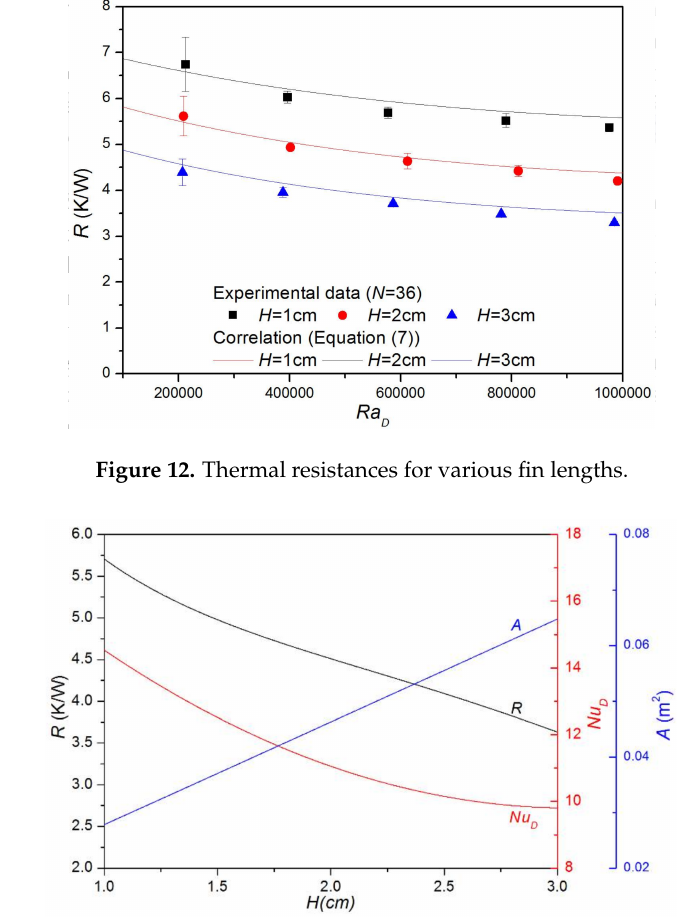
Figure 13. Effects of fin length on effective surface area, Nusselt number, and thermal